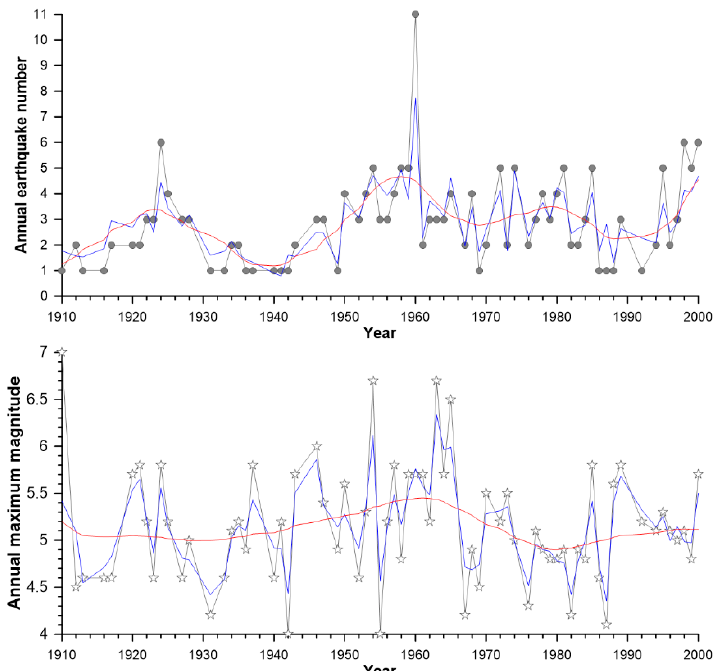
Figure 6. Fit of the recorded annual number and the annual maximum earthquake magnitude (grey line) by the seasonality and trend components combined (blue line) and by the trend component alone (red line).